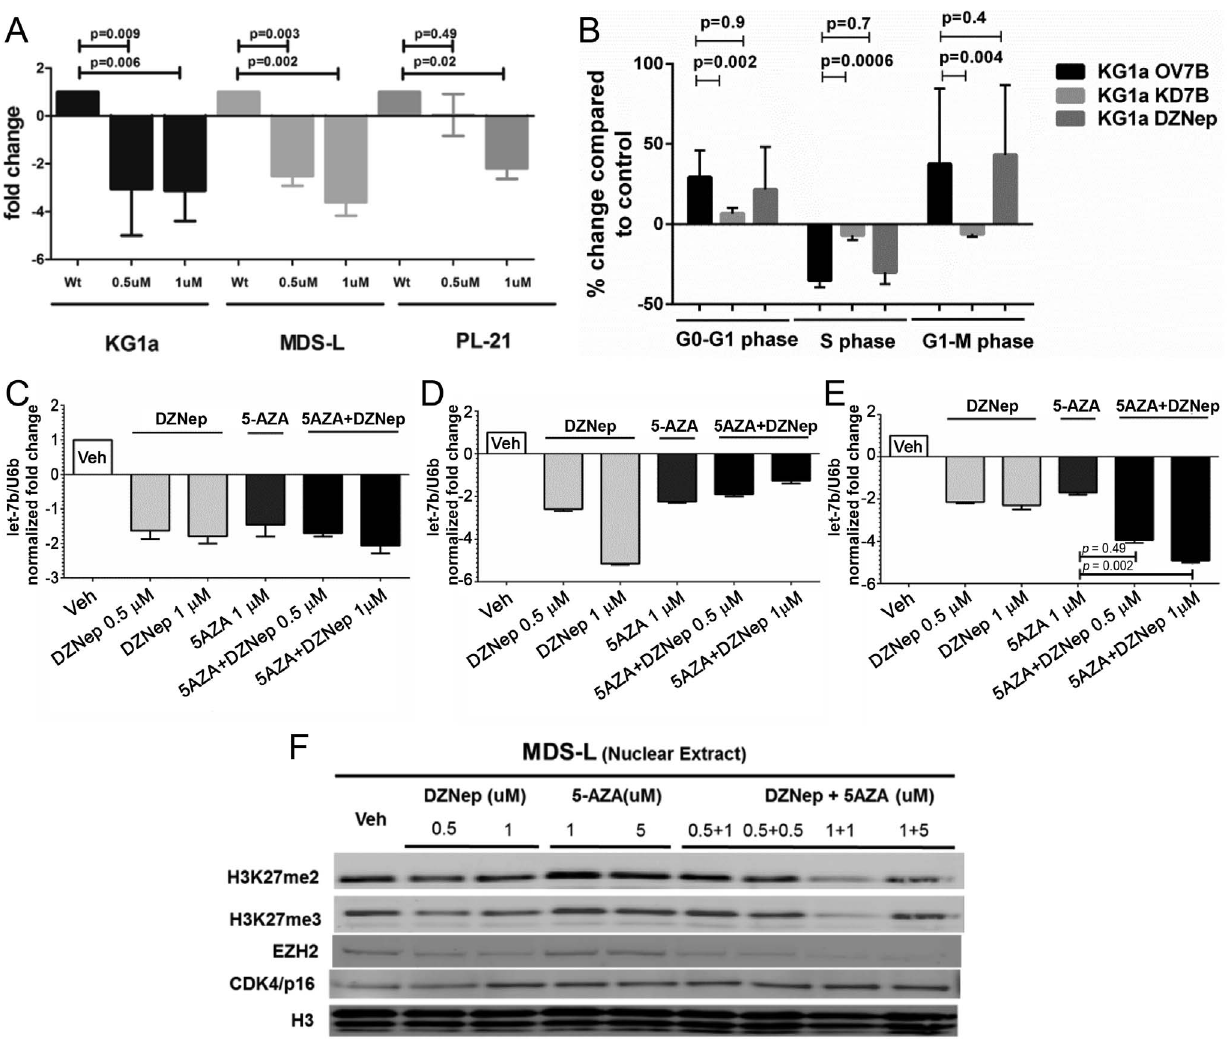
Figure 5. Effects of DZNep and 5AZA on let-7b and EZH2 levels. A ) DZNep exposure at different concentrations (0.5 m M and 1 m M) significantly reduced let-7b expression in KG1a, MDS-L and P-L21 cells (p=0.005 and p=0.002, respectively). The results are displayed as mean 6 SEM of 3 similar experiments (Student t-test). B ) KG1a cells treated with DZNep showed decreased cells in S phase. C ) Treatment of KG1a cells, D ) healthy donor cells, and E ) cells from MDS marrow, with DZNep, 5AZA or a combination of both, decreased let-7b expression, more so with the combination than with 5AZA alone (p=0.049 and p=0.002, respectively, results show the mean 6 SEM of 3 experiments; Student’s t-test, U6B served as loading control)); F ) MDS-L cells showed decreased H3K27m2 and H3K27m3, and decreased EZH2 protein expression.; Histone H3 served as nuclear loading control. The blots show one of 3 similar experiments.